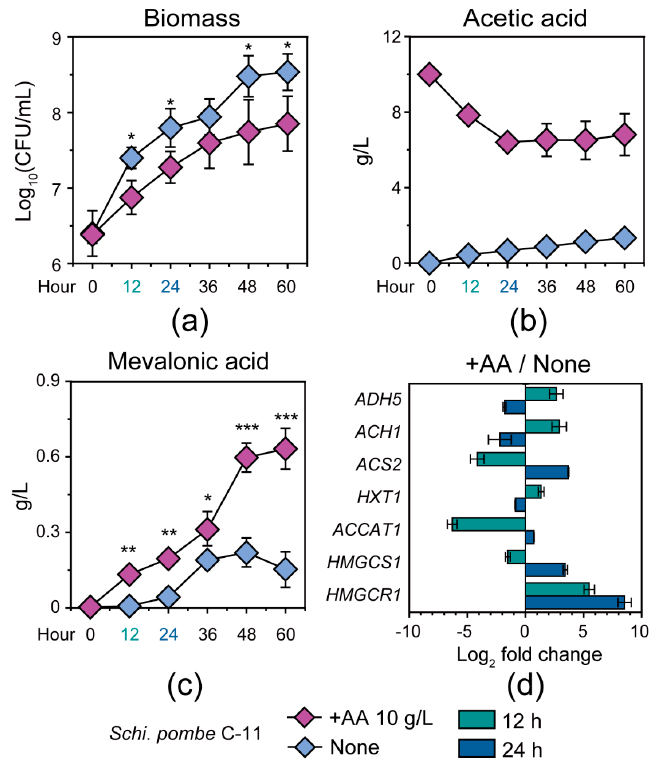
Figure 5. The microbial biomass, the metabolites concentration, and the gene expression of Schizosaccharomyces pombe C-11 in the + AA 10 g / L and none group samples in the mono-culture fermentation process. ( a ) The microbial biomass; ( b , c ) the concentration of acetic acid and mevalonic acid in the + AA 10 g / L and none group samples during the fermentation process; ( d ) the relative expression ratios of genes ADH5 , ACH1 , ACS2 , HXT1 , ACCAT1 , HMGCS1, and HMGCR1 in + AA 10 g / L group as compared to the none group at 12 h and 24 h. In the + AA 10 g / L group samples, the mono-culture process using Schi. pombe C-11 under initial concentration of 10 g / L acetic acid; and in the none group samples, the mono-culture process using Schi. pombe C-11 without initial concentration of 10 g / L acetic acid. The length in each square frame represents relative gene expression ratio based on real-time quantitative PCR at 12 h and 24 h, respectively. Data are expressed as mean ± SD from biological triplicates. Error bars indicate standard deviation from three independent experiments and asterisks represent significant di ff erences between the two groups (* p < 0.05, ** p < 0.01, *** p < 0.001, Mann–Whitney U